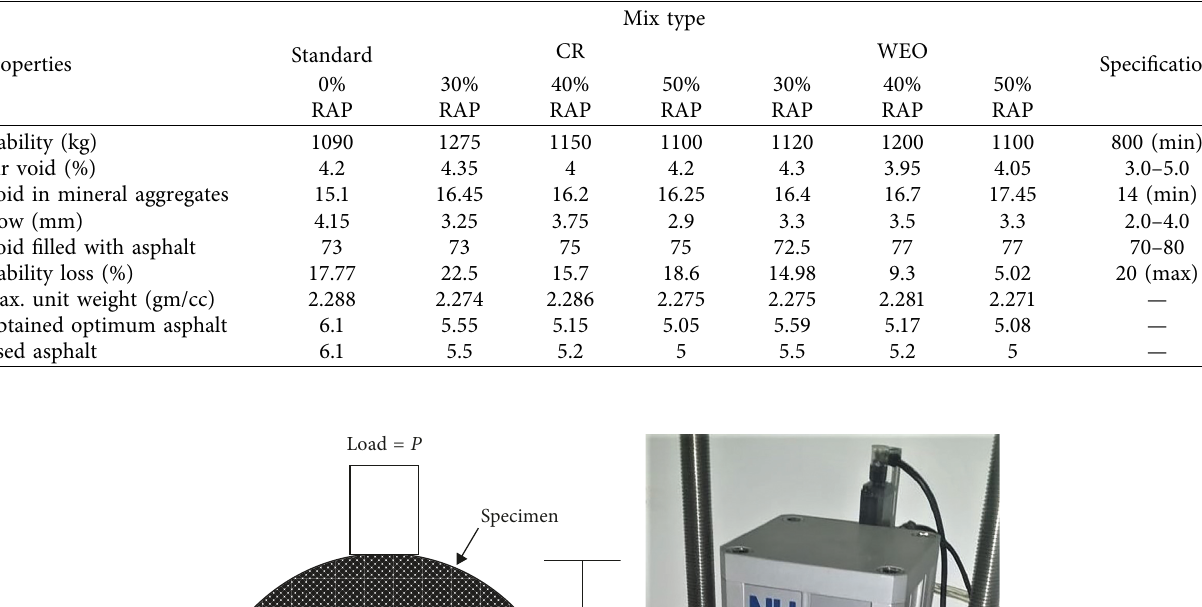
Table 4: Summary of Marshall properties.